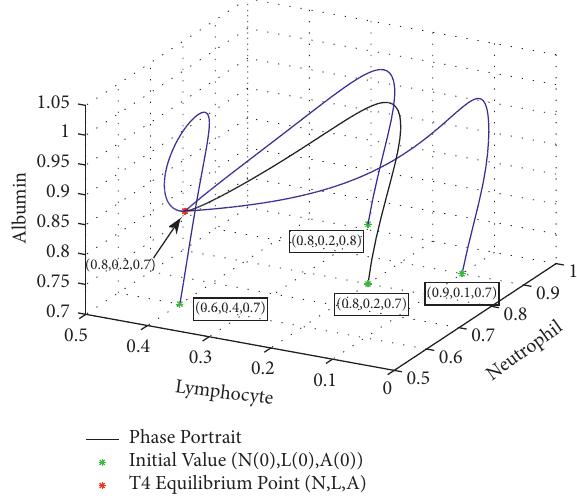
Figure 4: Phase portrait of the system solution with four different initial conditions.